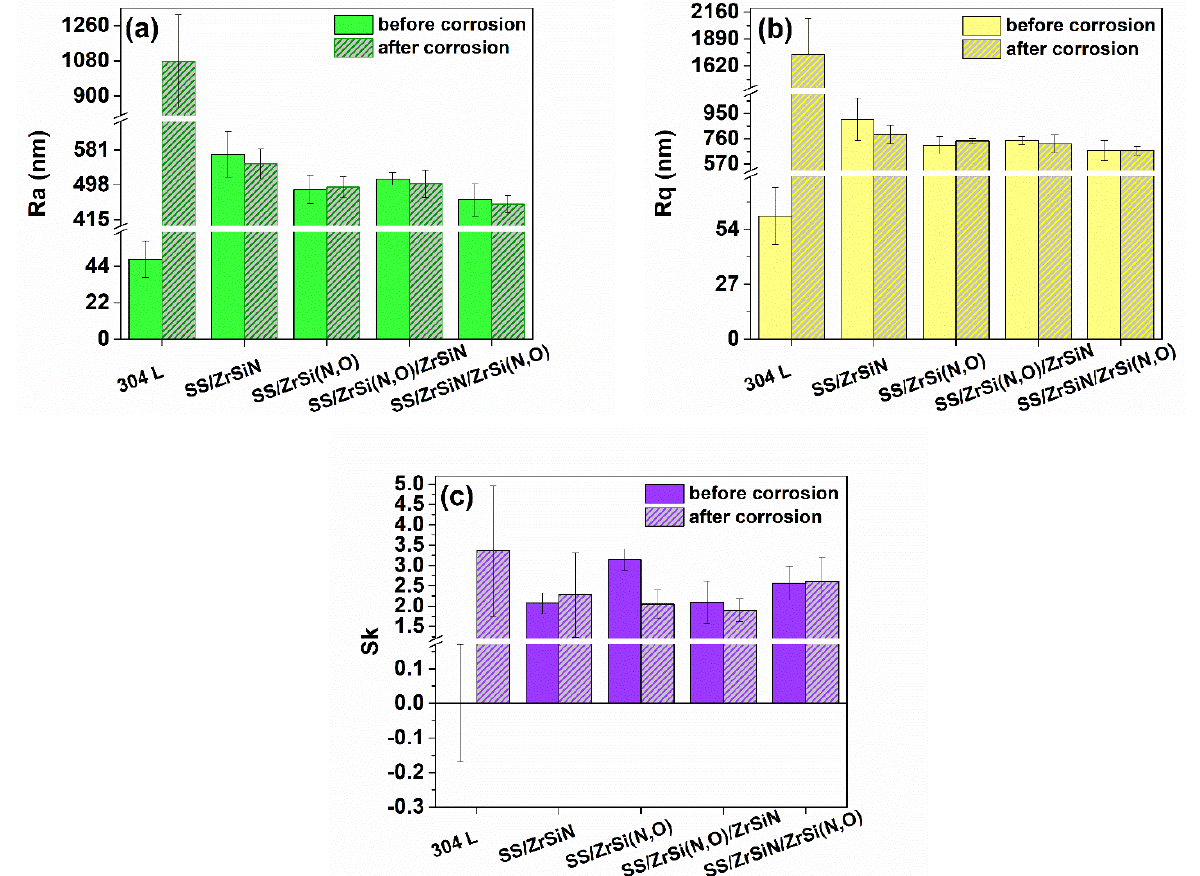
Figure 8. Roughness parameters of the investigated specimens before and after corrosion measurements: Ra ( a ), Rq ( b ), and Sk ( c ).